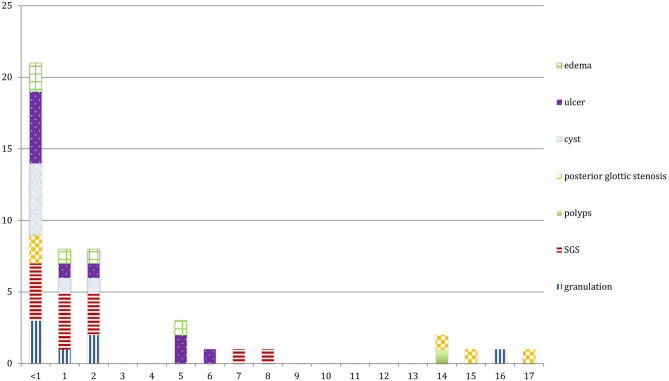
Lesions depending on the age. SGS, Subglottic stenosis.